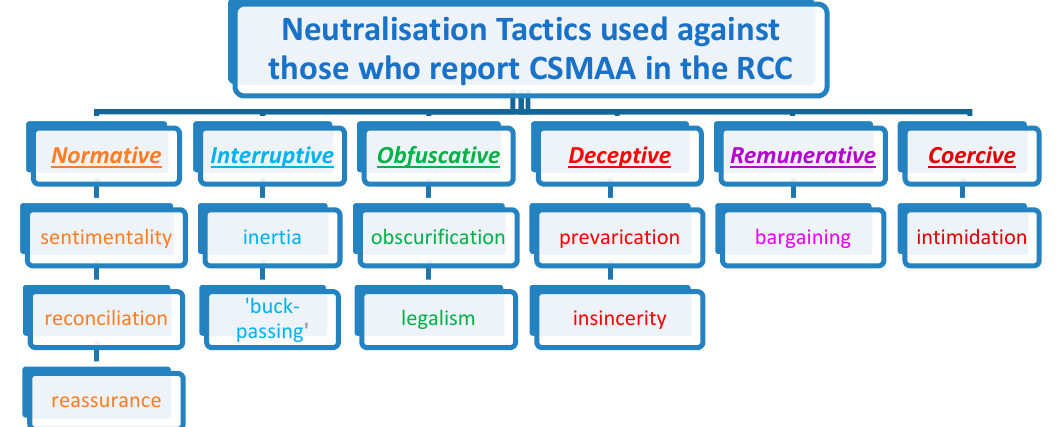
Figure 1. A new version of tactics and modes of institutional neutralisation (de Weger 2020, p. 229).